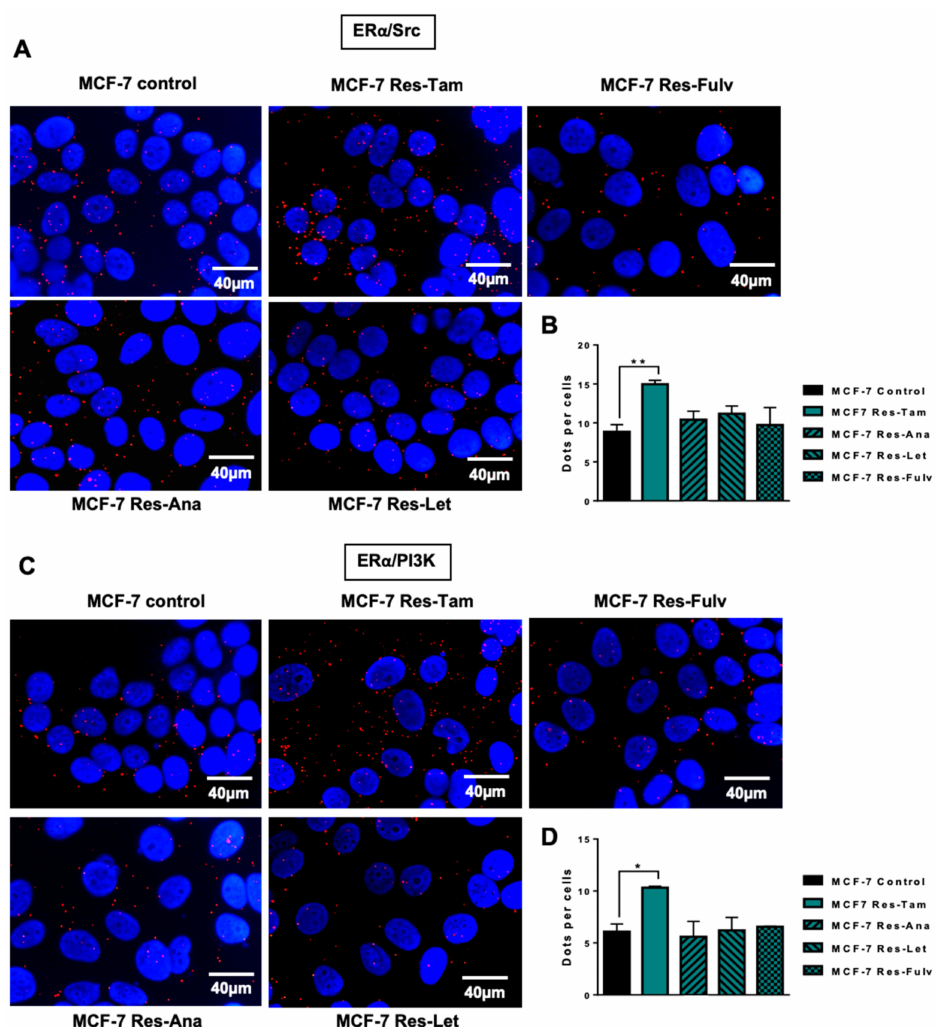
Figure 4. ER α / Src and ER α / PI3K expression in MCF-7 cells resistant to several endocrine therapies. MCF-7 cells resistant to tamoxifen (Res-Tam), fulvestrant (Res-Fulv), anastrozole (Res-Ana) and letrozole (Res-Let) were generated and the levels of interaction between ( A ) ER α / Src or ( C ) ER α / PI3K were determined by proximity ligation assay using fluorescent probes ( B , C ). Quantification of results obtained in ( A , C ) was performed by counting the number of signals per cell ( n = 100 cells) using the image J “counter cells” plugin. The graph is representative of three independent experiments. Significance ( p -value) between treatments was determined using the Student t-test. * p < 0.05; ** p <